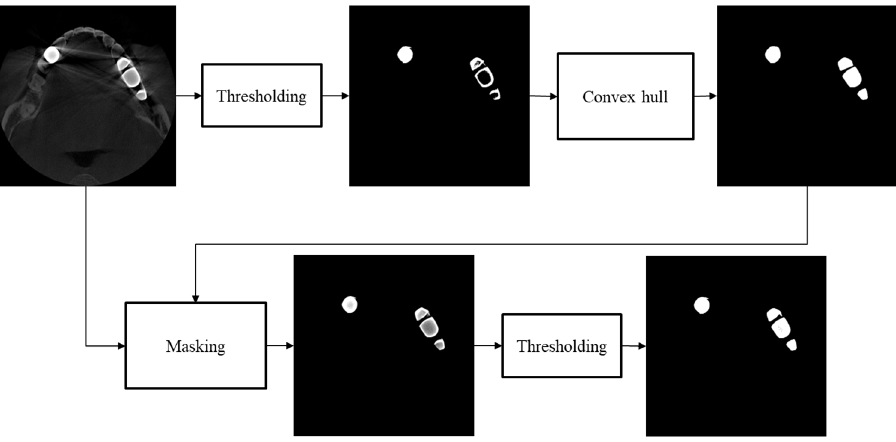
Figure 7. The workflow of the metal segmentation.